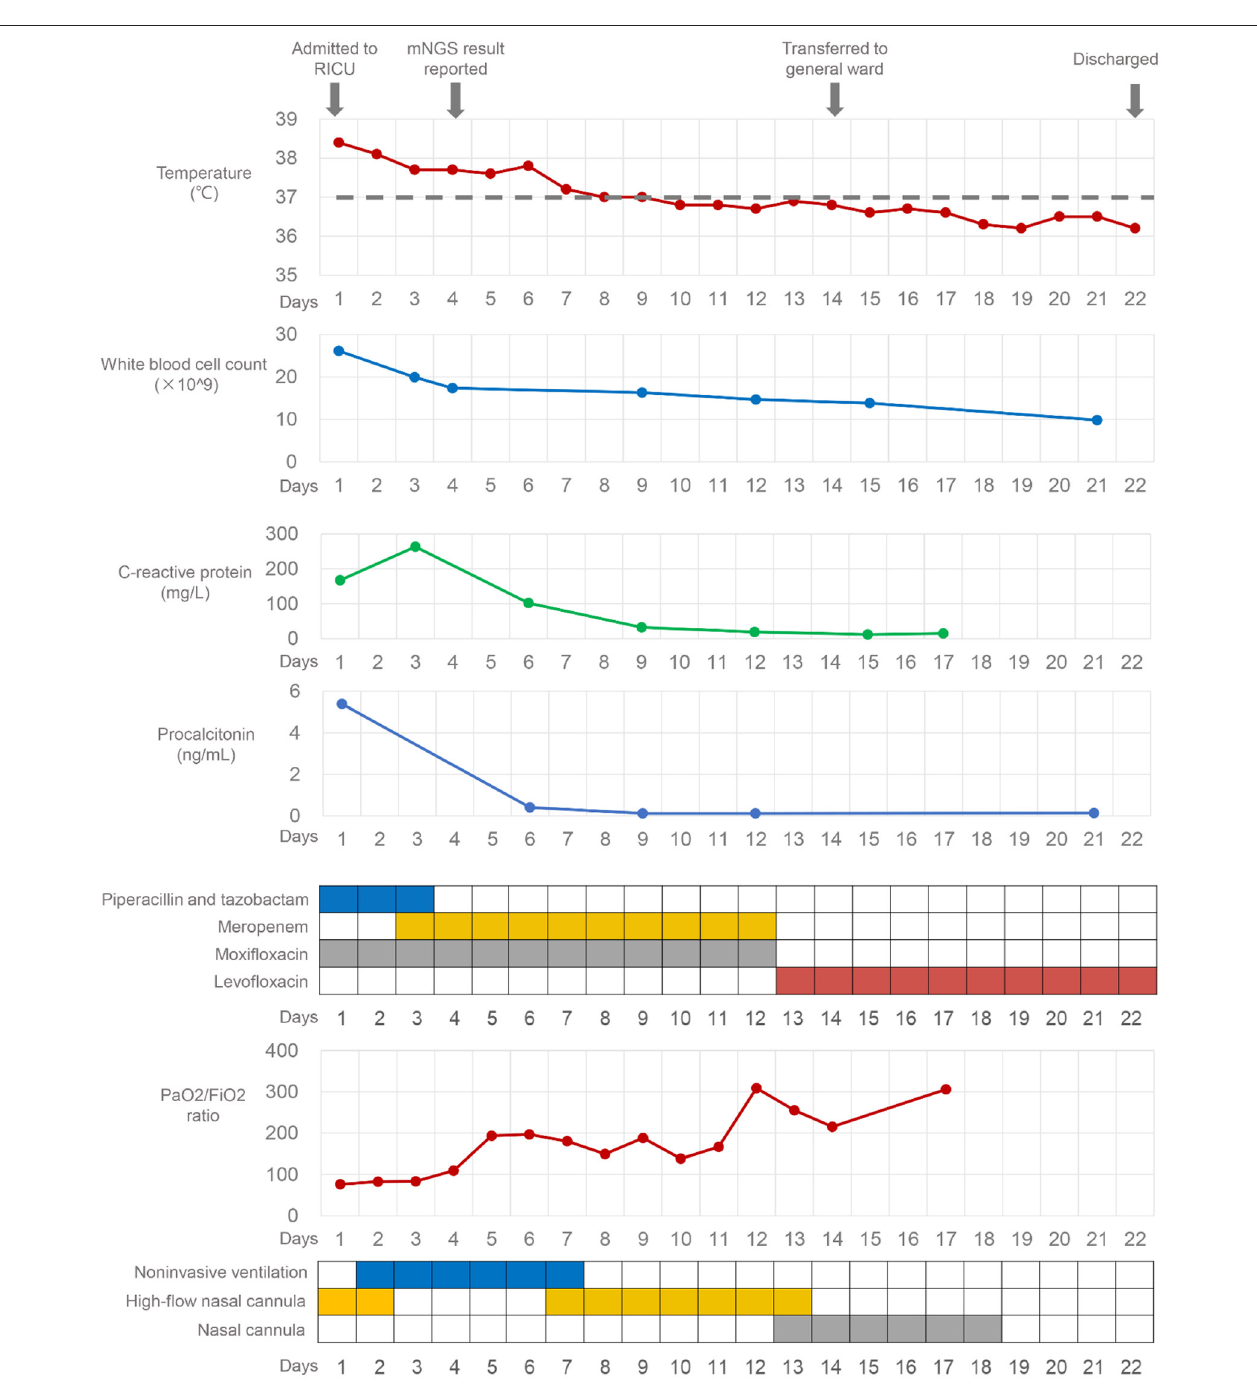
FIGURE 2 | The clinical course of the patient with Legionella gormanii infection.